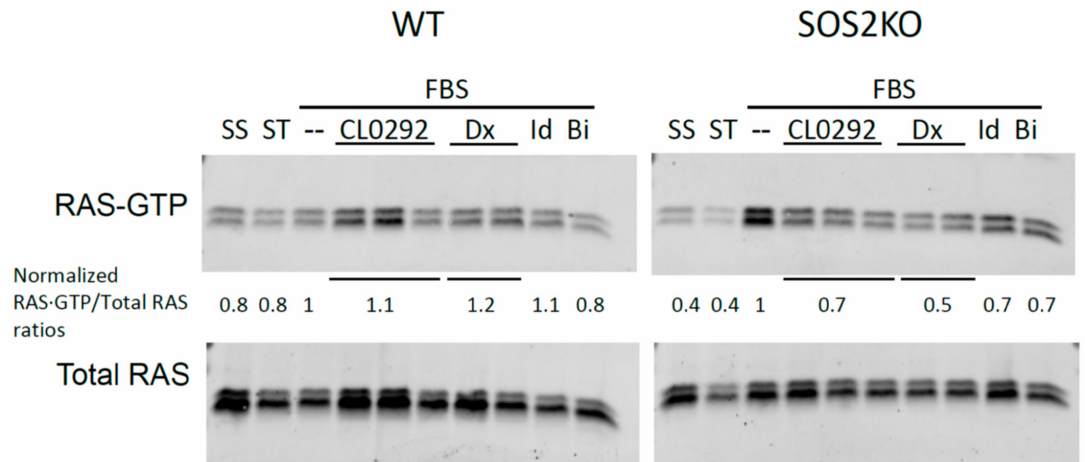
Figure 2. Pull-down assays using the inhibitors of the exchanger reaction on MEFs. Inhibition of Ras activation was observed only in the absence of the SOS2 protein, indicating that the anthraquinones used in this study selectively inhibit RAS activation by SOS1. Quantifications of the band intensities were converted into RAS · GTP/Total RAS ratios and normalized against the value obtained in stimulated cell without the inhibitors. Ratios between levels of RAS-GTP and total RAS are indicated for all assays. SS: Steady State; ST: Starved; –: DMSO; Dx: Doxorubicin; Id: Idarubicin; Bi: BI2852. (Quantification and statistics (SEM): (WT) SS n = 2, 0.8 ± 0.05; ST n = 2, 0.8 ± 0.18; CL0292 n = 6, 1.1 ± 0.13; Doxorubicin n = 4, 1.2 ± 0.22; Idarrubicin n = 2, 1.1 ± 0.24; BI-2852 n = 2, 0.8 ± 0.01. (SOS2 KO) SS n = 2, 0.4 ± 0.18; ST n = 2, 0.4 ± 0.26; CL0292 n = 6, 0.7 ± 0.10; Doxorubicin n = 4, 0.5 ± 0.10; Idarrubicin n = 2, 0.7 ± 0.13; BI-2852 n = 2, 0.7 ±